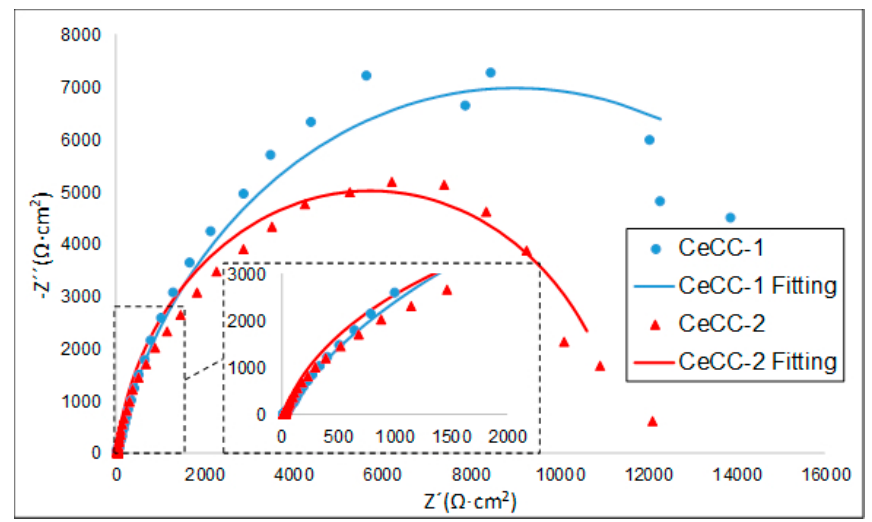
Figure 10. Nyquist impedance plots of CeCC-1, CeCC-2 and their fitting to the equivalent circuit of Figure 11.